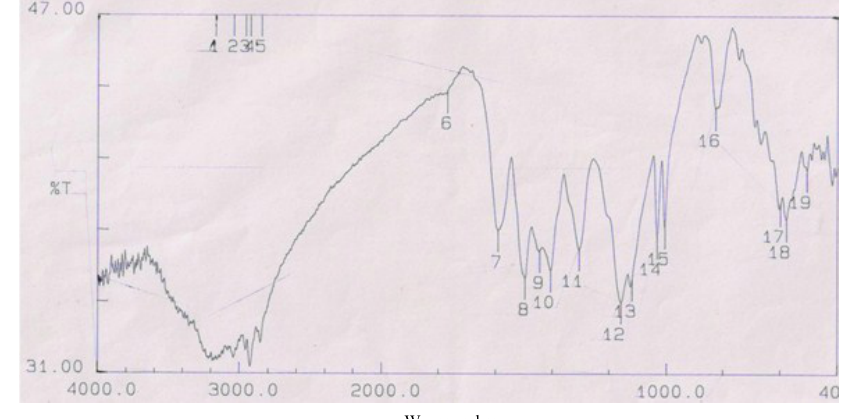
Figure 2. FTIR spectra of BF